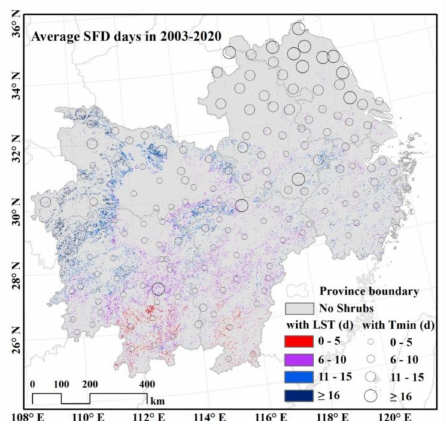
Figure 7. Spatial characteristics of average SFD days for tea plants in 2003–2020 in the middle and lower reaches of the Yangtze River region, China. Pixels with different colors and different size circles were the average SFD days calculated from satellite-based estimates of land surface temperature (LST) and with ground-based minimum temperature (Tmin) observations,